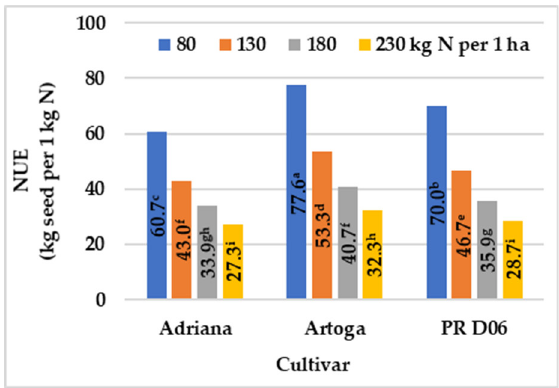
Figure 4. The effect of N rate on the nitrogen use efficiency of winter oilseed rape cultivars, across Figure 4. The e ff ect of N rate on the nitrogen use e ffi ciency of winter oilseed rape cultivars, across years. Means with the same letters do not differ significantly at p ≤ 0.05 in Tukey`s test. years. Means with the same letters do not di ff er significantly at p ≤ 0.05 in Tukey‘s test. Energies 2020 , 13 , 4654 Regardless of cultivar, N rates higher than 180 kg ha −1 exerted a yield-forming effect only in combination with soil-applied S. In treatments supplied with high rates of N (180–230 kg N ha −1 ), an increase in the N rate by 1 kg without supplementary S fertilization was not productive in any of the